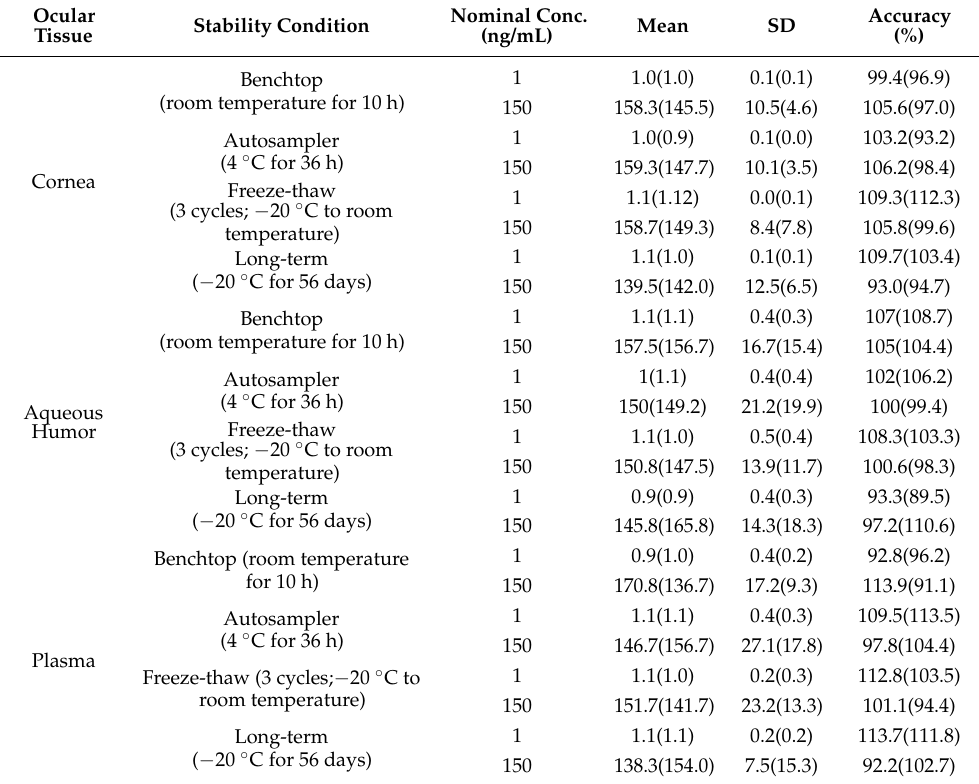
Table 4. Stability of MFH and DSP under various storage conditions at both the LQC and the HQC (n =